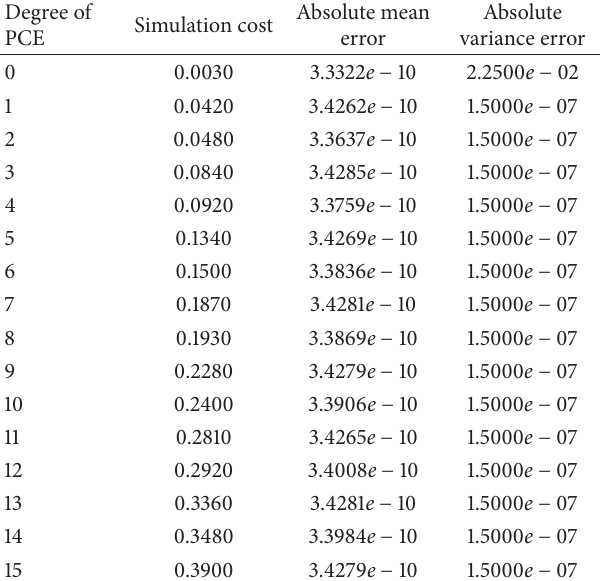
Table16:Computationaltimecostsfordeterminingtheaverageand variance of the Vasicek interest rate 𝑅 𝑇 , at time 𝑇 = 1 , achieved